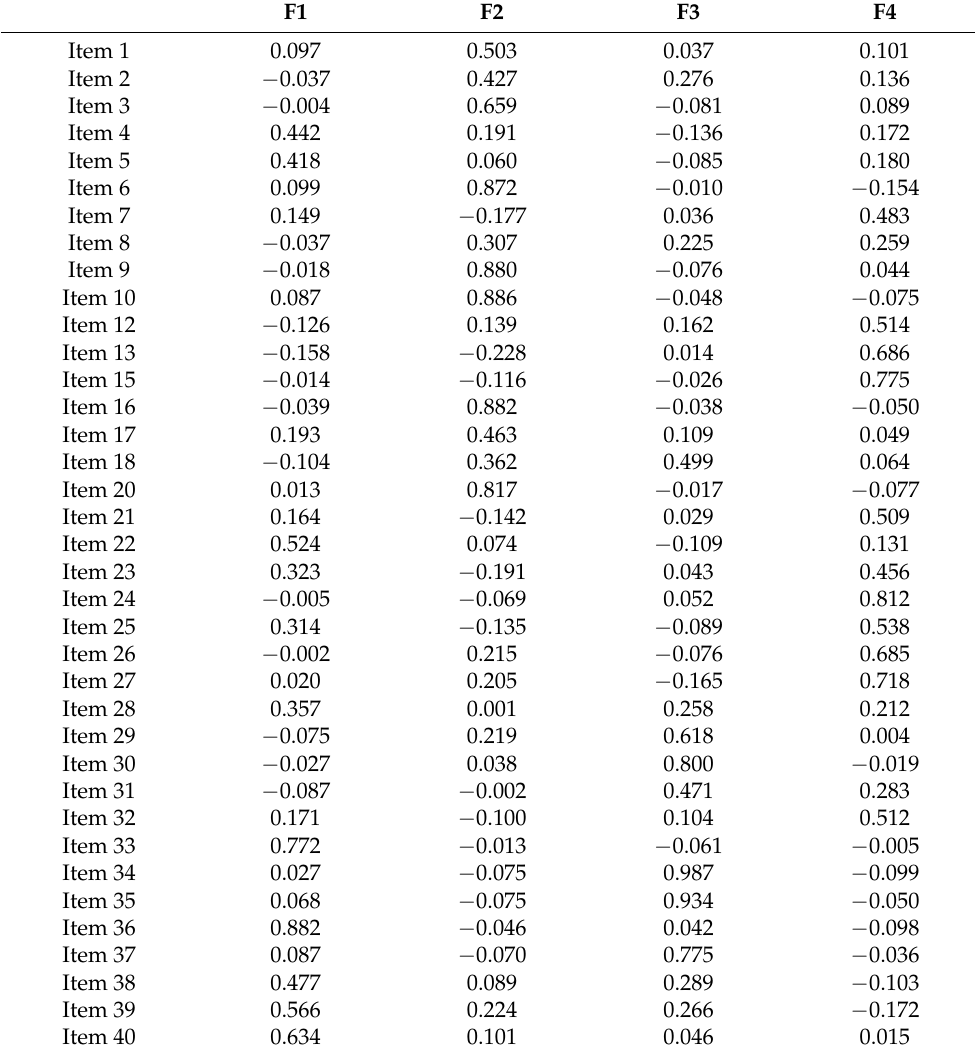
Table 3. Factorial loads (after rotation) of the 4-factor, 37-item model obtained on the first sample ( n =